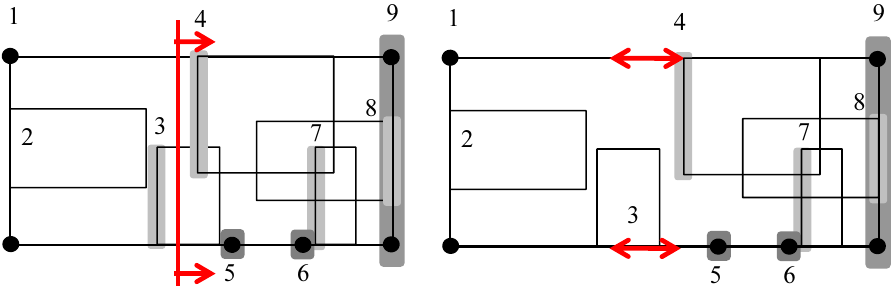
Figure 15. The step of the plane sweep algorithm that resolves overlaps for Label 3.